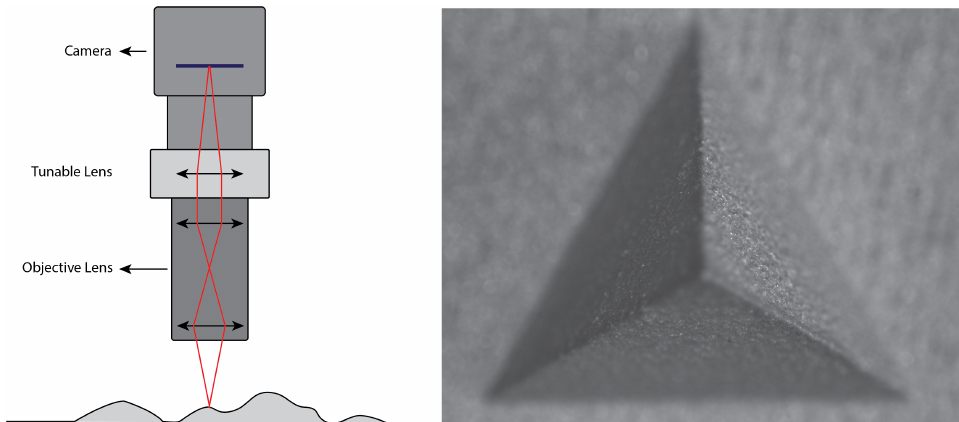
Figure 1. Left : a schematic representation of a tunable lens-based shape-from-focus system. Right : an image with narrow depth of field from the shape-from-focus system that was used in this research.